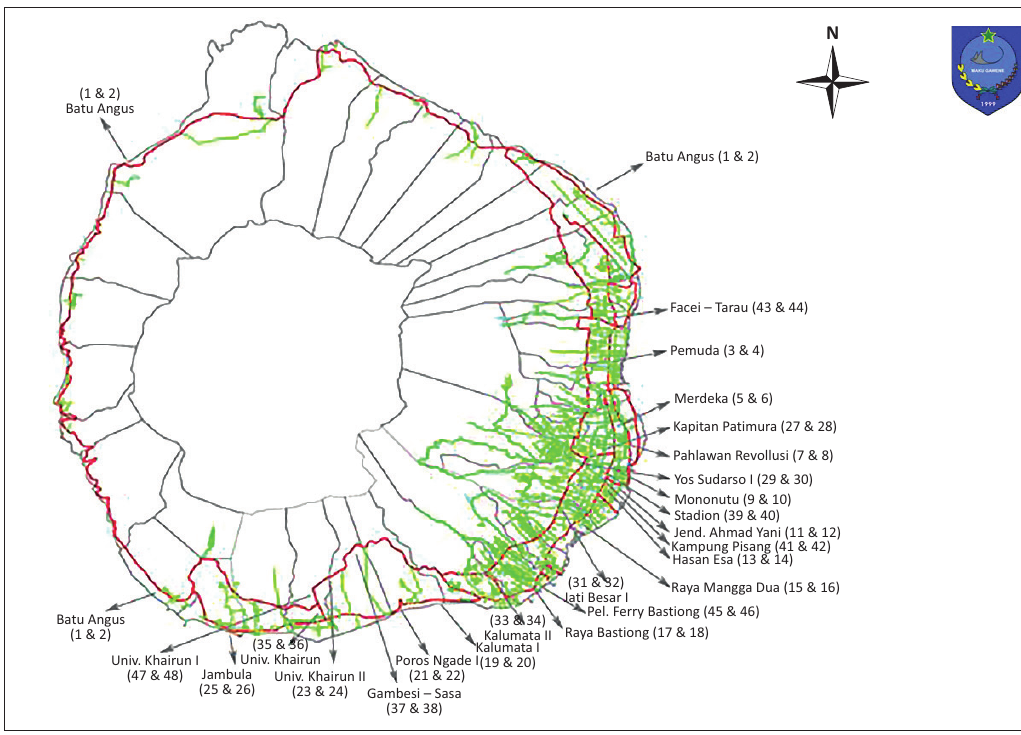
FIGURE 5 : Ternate city road